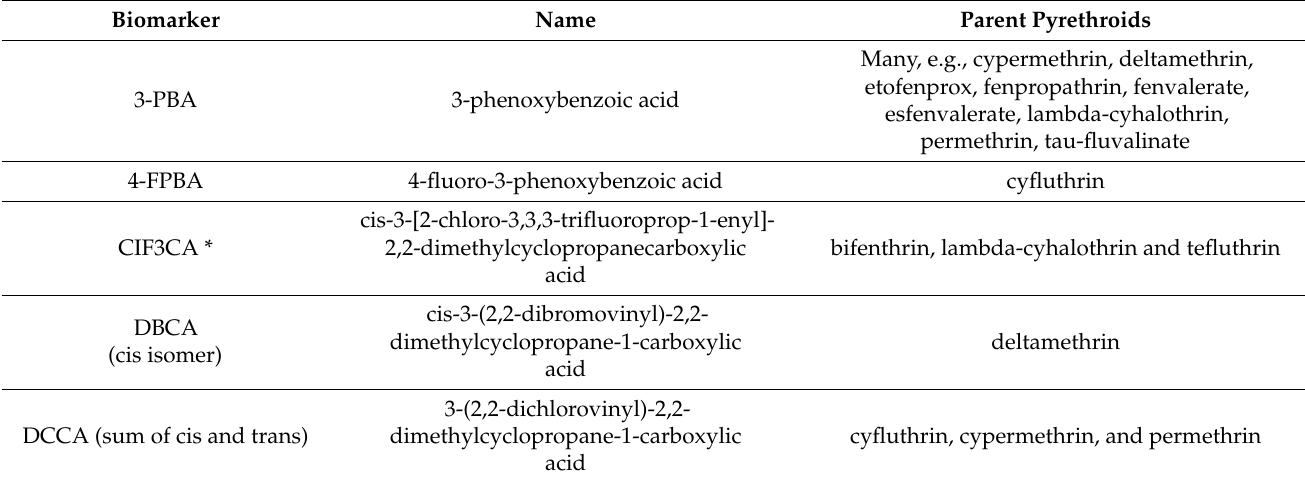
Table 2. Selected pyrethroid urinary markers and active substances.